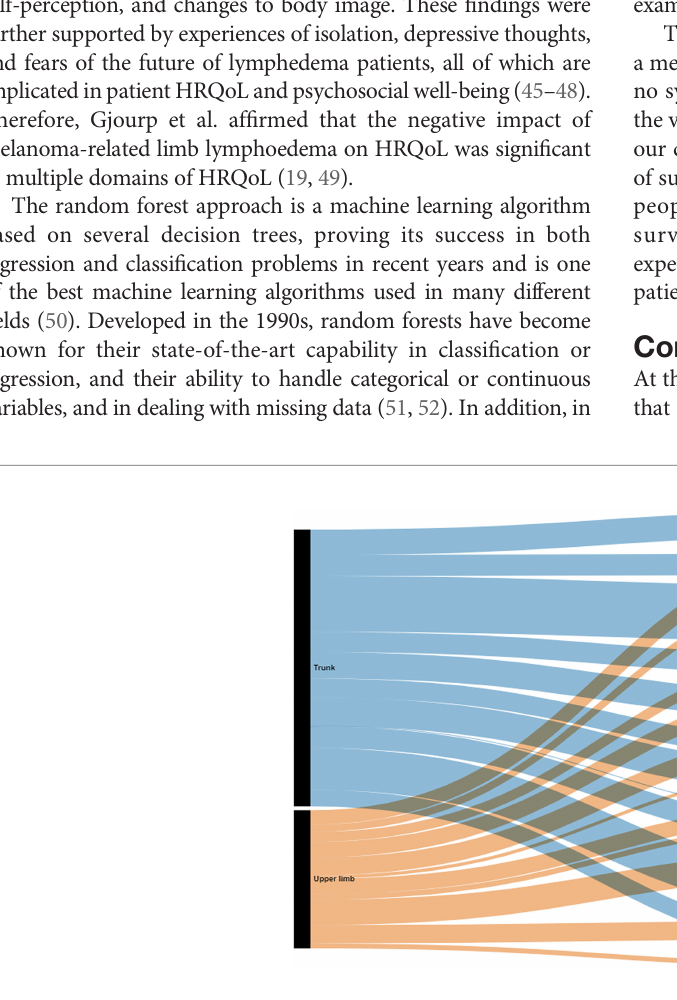
FIGURE 2 | Sankey diagram for total increase in node purity in upper limb and trunk melanoma of variables.